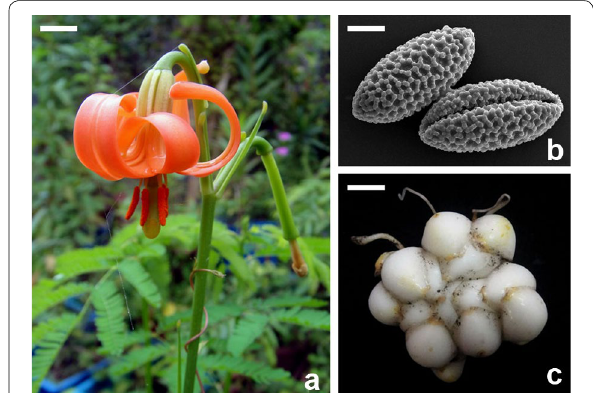
Fig. 3 Flower and bulb morphology of regenerated Lilium callosum derived from scale culture in vitro. a Orange flower color, reflexed perianths, stigma, and anthers containing pollen showed structures similar to those observed in situ. (Bar